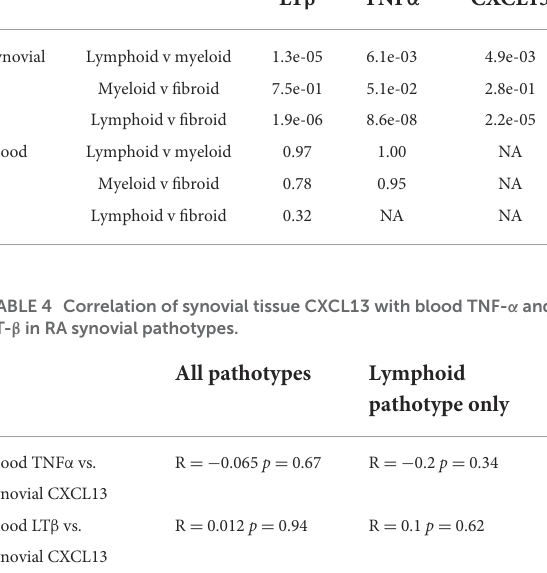
Corrected p -values